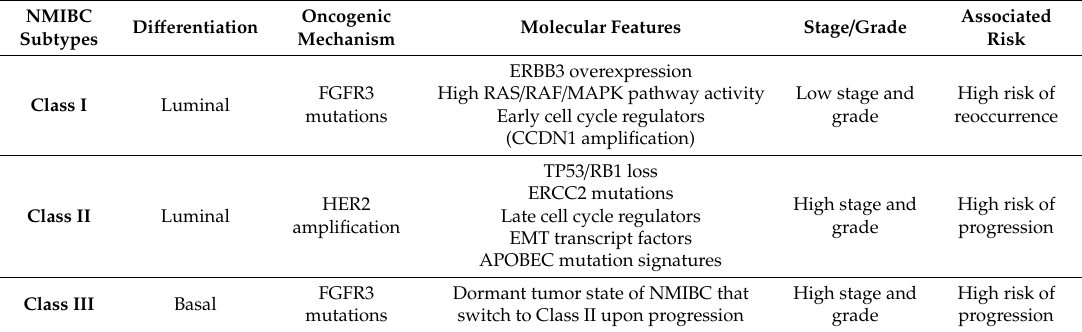
Table 1. Molecular subtypes of non-muscle invasive bladder cancer and their main features.